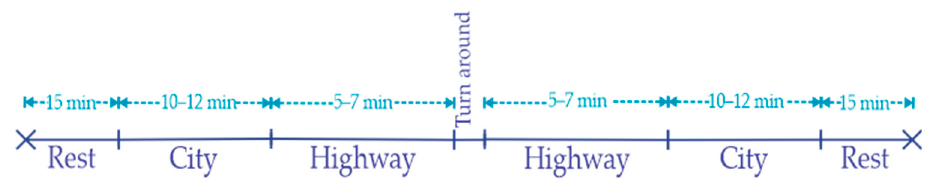
Figure 2. Description of the driving